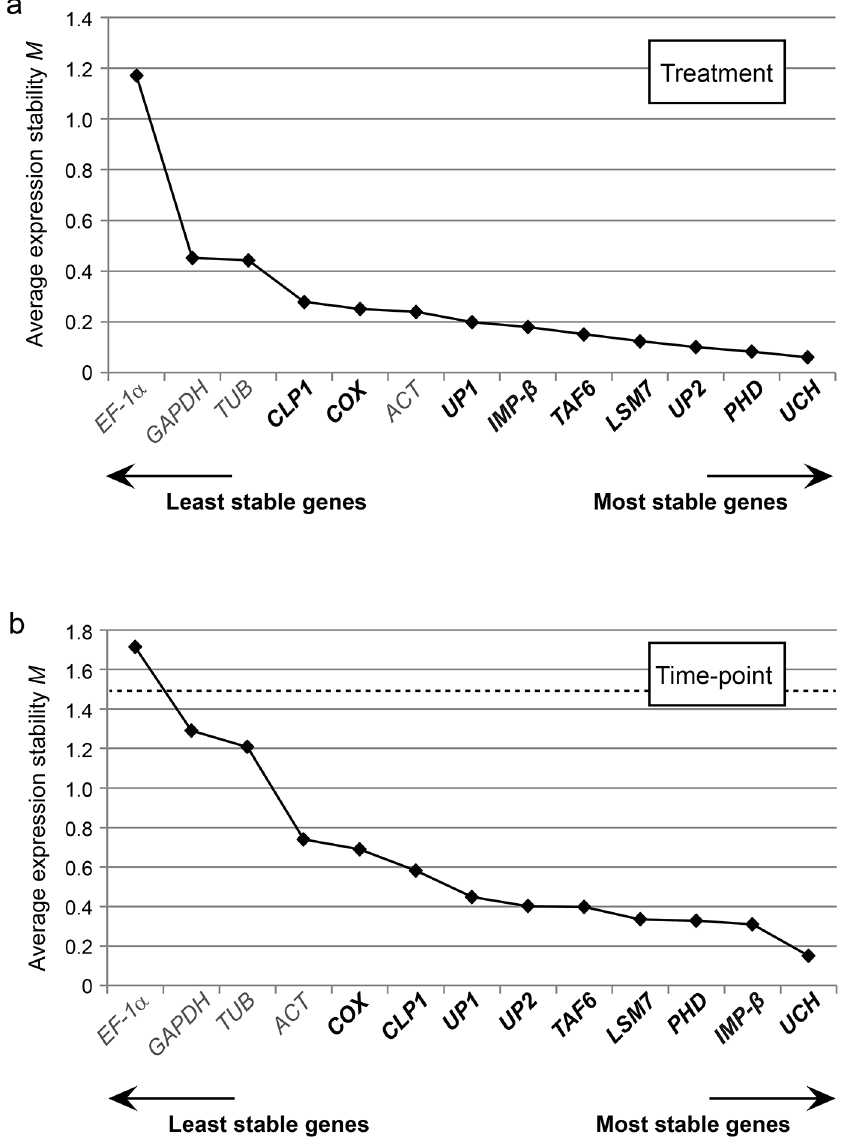
Fig 8. Expression stability of candidate reference genes in Xcv -infected and mock-treated pepper plants evaluated by NormFinder. Ranking of C . annuum reference genes based on expression stability calculated by NormFinder (n = 48). New reference gene candidates are indicated in bold. The cut-off value for reliable reference genes is indicated by a dashed line. Sample groups were defined based on (a)